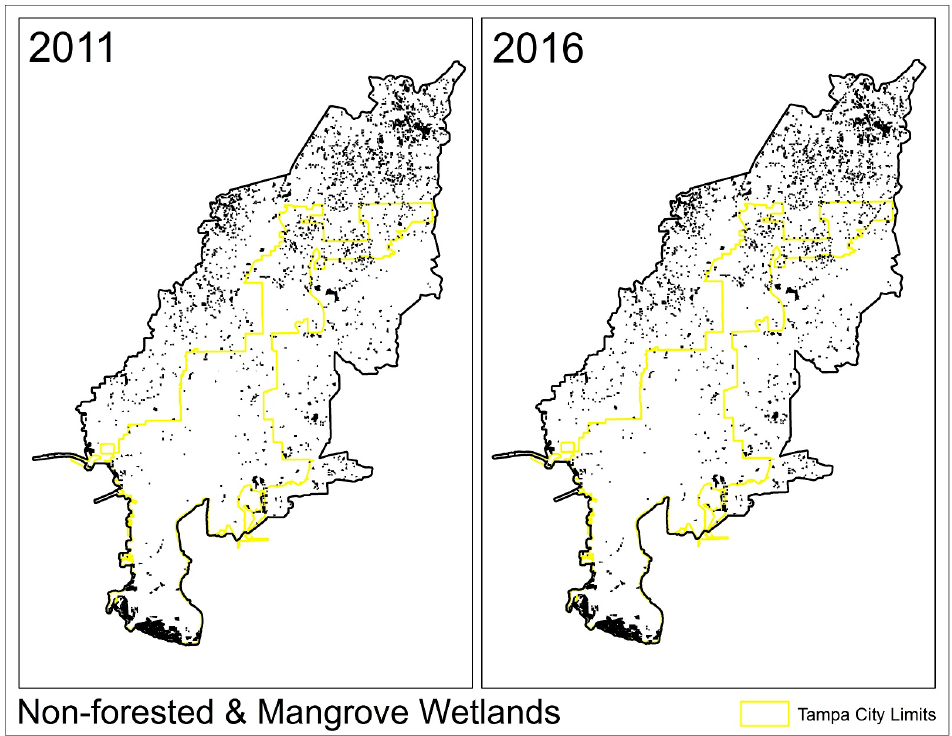
Figure A14. Observed (2011) and Modeled (2016) LULC distribution for the “Non-forested & Mangrove Wetlands” class.